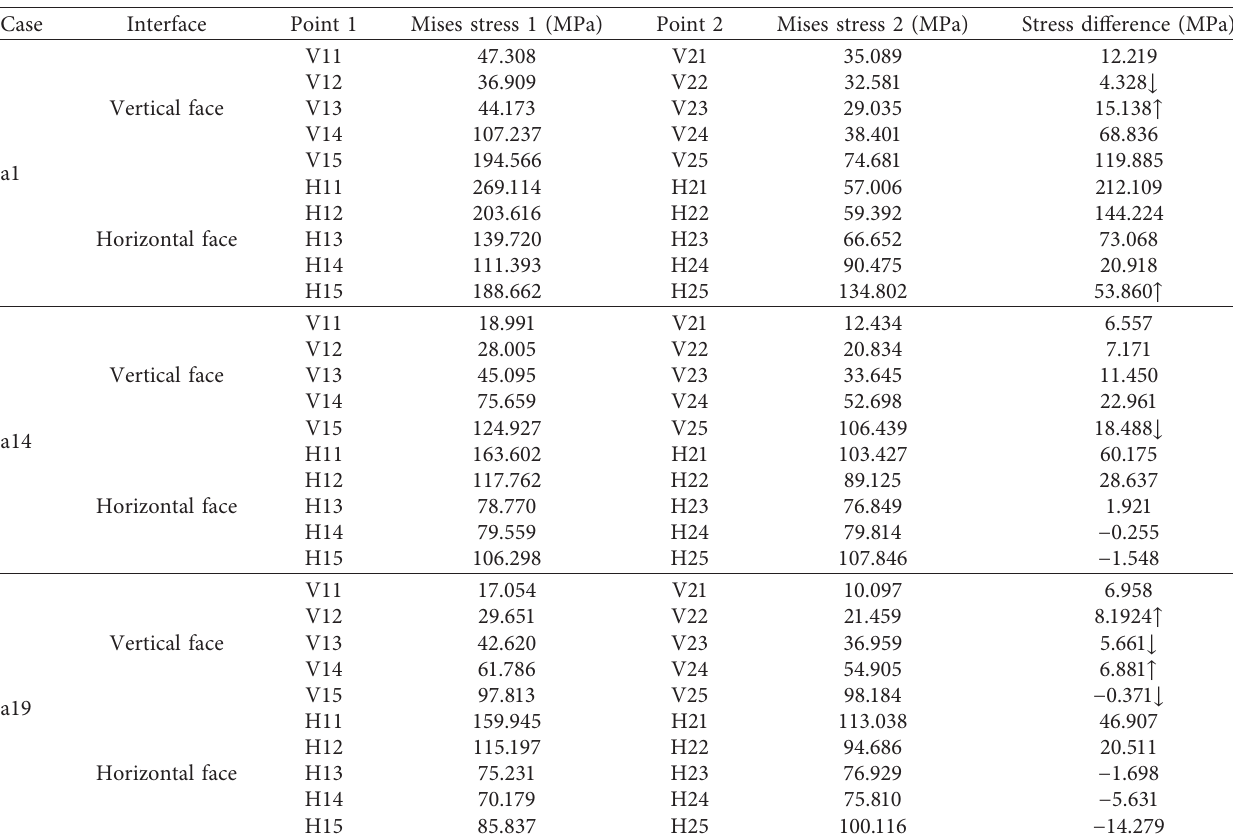
Table 4: Mises stress difference for interface.